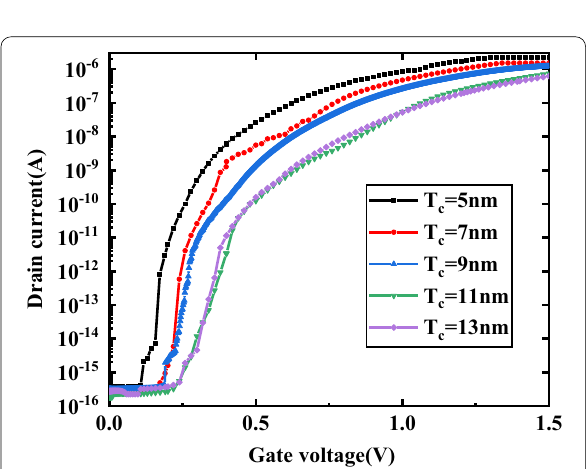
Fig.6 Transfer characteristics of DM-DSTGTFET biosensor for different values of cavity thickness ( T c ) at V d